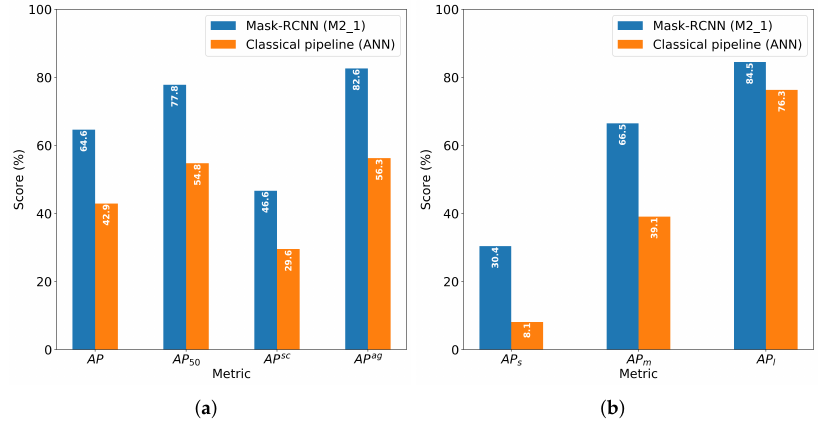
Figure 8. Comparison of results for Mask-RCNN and classical approach. ( a ) Default AP, ( b ) Size- dependent